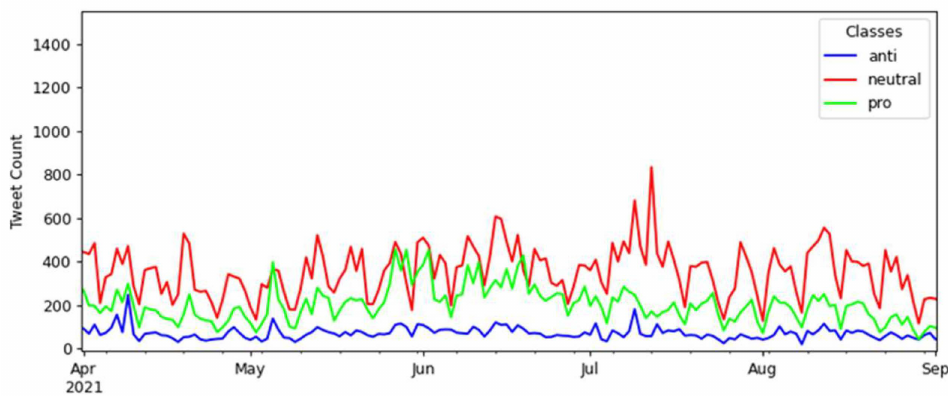
Figure 10. Details of the interval between the beginning of April and the end of August